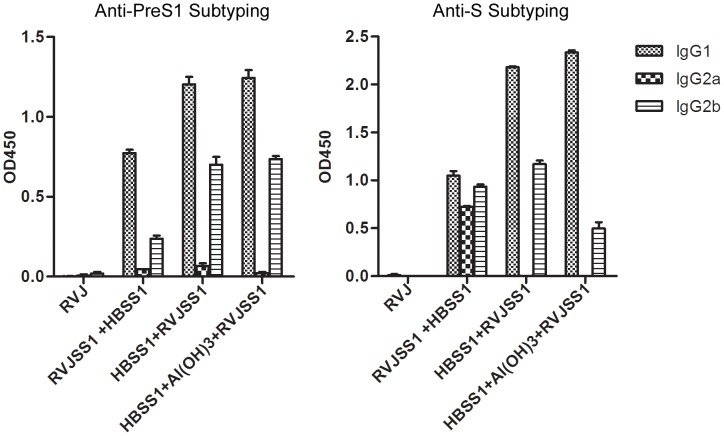
Subtype analysis of the HBV antigen-specific IgGs in sera of mice immunised with different vaccine combinations.Antigen specific IgG1 and IgG2a or IgG2b levels were determined using an IgG isotyping ELISA, as described in Materials and Methods. Sera were collected 2 weeks after the last immunization and diluted 1∶100. Bars indicate the average OD value at 450 nm (OD450) of each group.